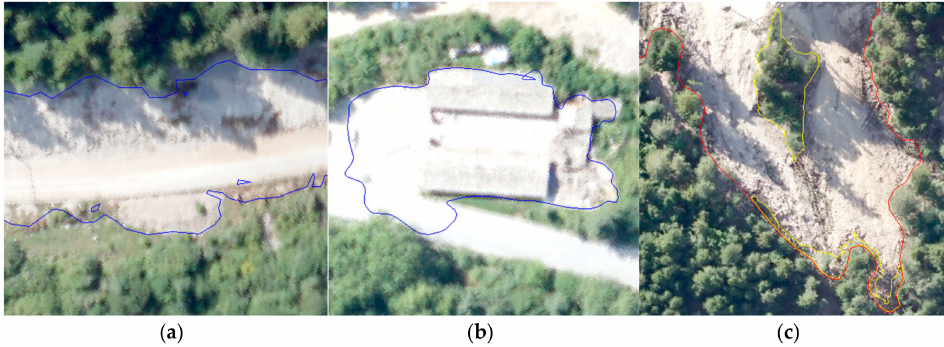
Figure 9. ( a ) Incorrect extraction; ( b ) incorrect extraction; and ( c ) missed mentions.